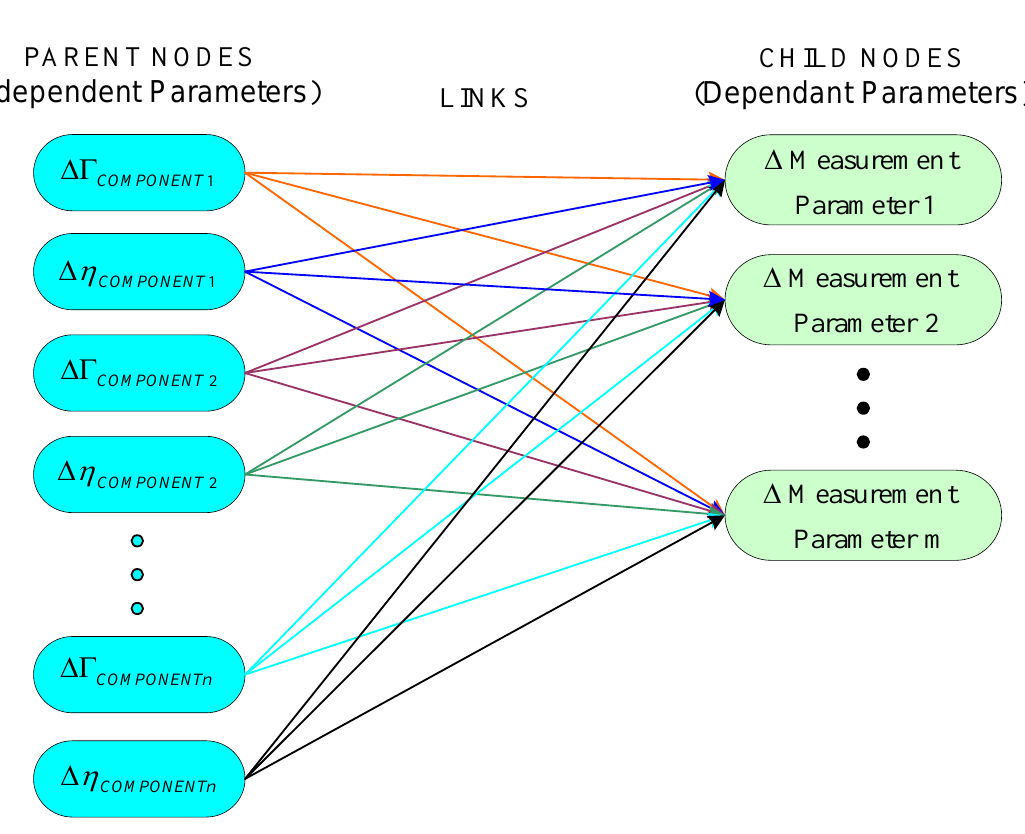
Figure 12. Typical Bayesian Belief Network (BBN) layout for engine fault identification, adapted from Kadamb (adapted from [186].